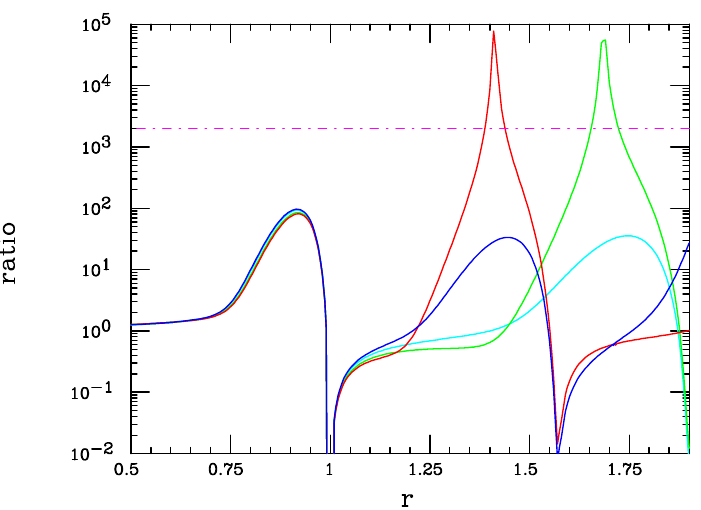
Figure 6 . Same as in the lower panel of the previous (cid:12)gure for BM1 (green) and BM4 (red) but also for these same BM (in cyan and blue, respectively) where we modify the signs of the product of couplings of the SM and DM of the KK states as discussed in the text for comparison. The horizontal dash-dotted) line is a guide to the eye for K = 2 (cid:1) 10 3